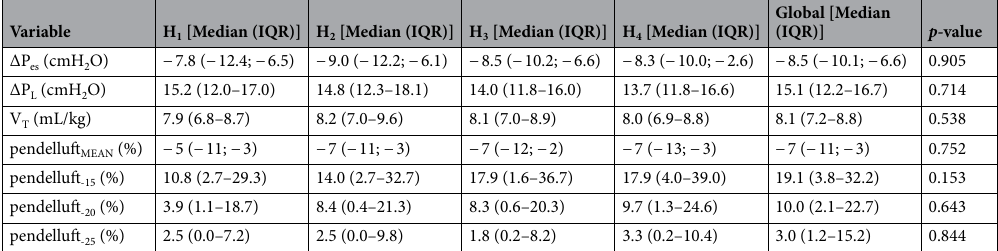
biomarkers, simple regressions were fitted. The mean pendelluft magnitude and frequencies at different pendel- luft magnitudes were associated with V T at the dependent lung regions but not with total V T . We did not observe significant associations between pendelluft and ΔP es nor ΔP L suggesting that pendelluft frequency might be only partially influenced by these variables (Supplementary Table S3). Even more , when ΔP es , ΔP L , and V T were